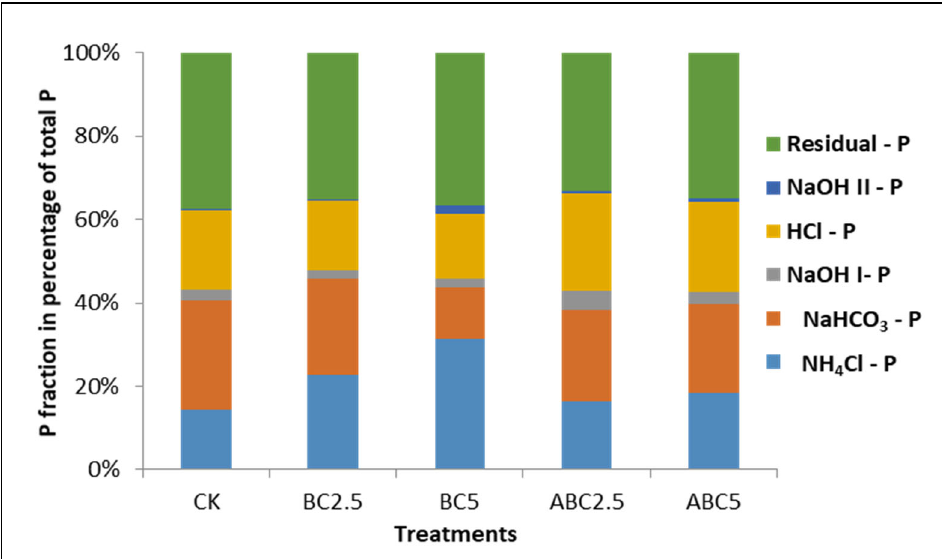
Figure 17. Effect of BC and ABC applied at different rates on P fractionation on soil treated with 300 ppm P. CK = Control, BC2.5 = Biochar applied at 2.5% w / w , BC5 = Biochar applied at 5% w / w , ABC2.5 = Acidified biochar applied at 2.5% w / w , and ABC5 = Acidified biochar applied at 5% w / w .